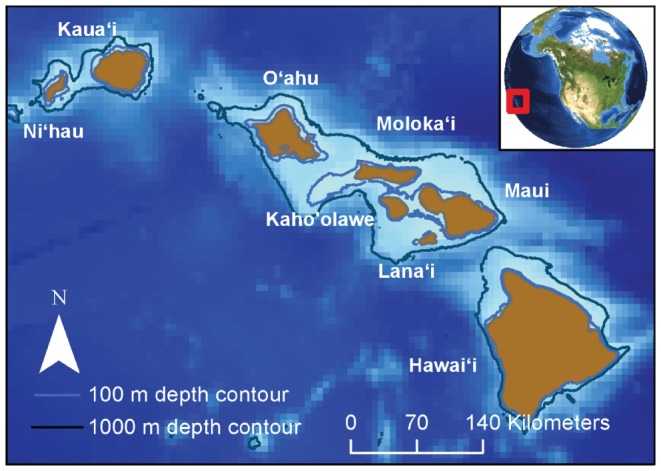
Location of the study site in the Hawaiian Archipelago.